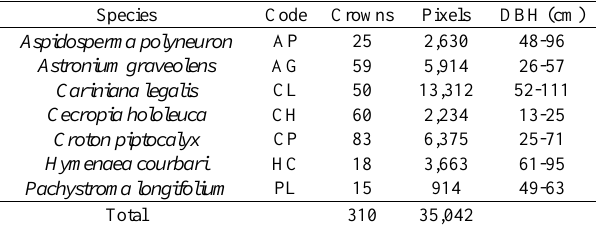
Table 1. Species list, number of crowns, pixels and minimum and maximum Diameter at Breast Height (DBH)